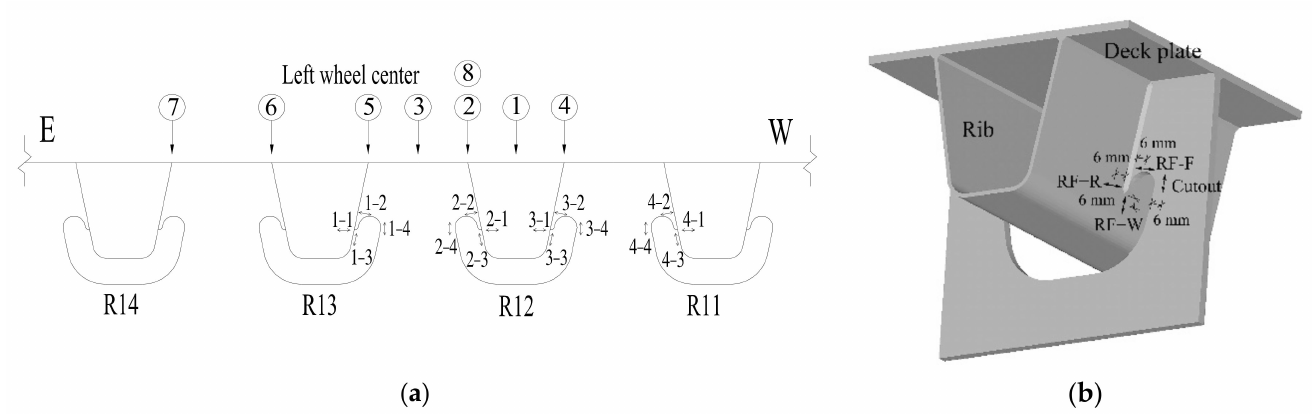
Figure 3. Strain gauge layout. ( a ) Gauge arrangement and transverse location of wheel center; ( b ) Stress location and direction at measured